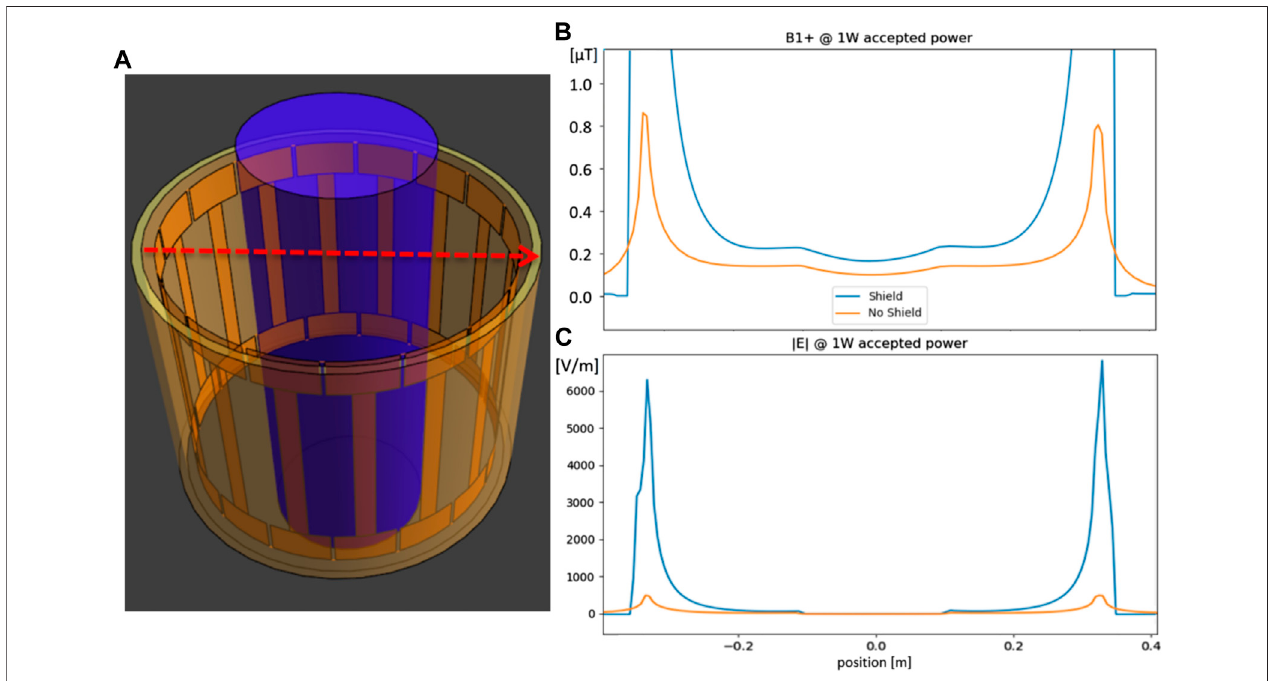
FIGURE 2 | (A) example geometry of birdcage using FDTD simulation. Dotted red line indicates position of the pro fi les of (B) and (C) . The loading phantom (blue cylinder)wasgiventissue-likeproperties.Birdcagedimensions areradius:352 mm, runglength:420 mm,endringwidth: 80 mm, rungwidth: 40 mm,and shieldradius: 372 mm. (B) B 1+ fi eld strength pro fi le with and without PEC shield. Since the fi elds are normalized to 1 W accepted power, the shield actually increases B 1 because without a shield, more power is radiated away. (C) Electric fi eld strength pro fi le with and without